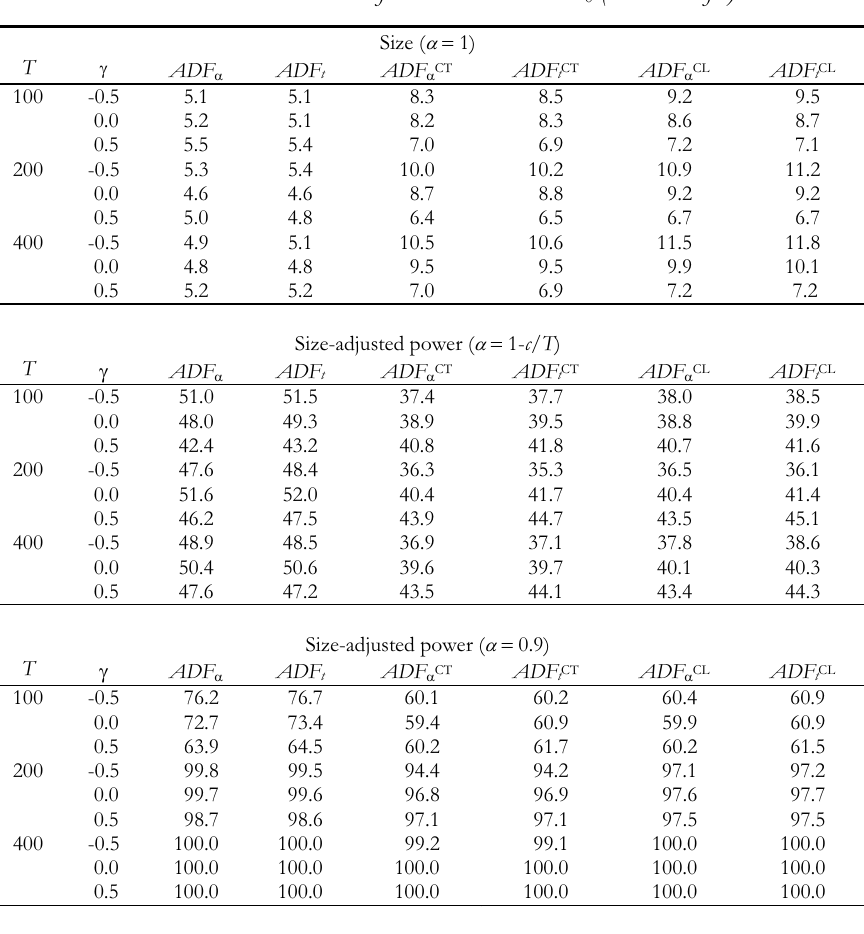
Comparison between standard Dickey-Fuller tests and the new unit root tests based on traditional level shift estimation. Model S